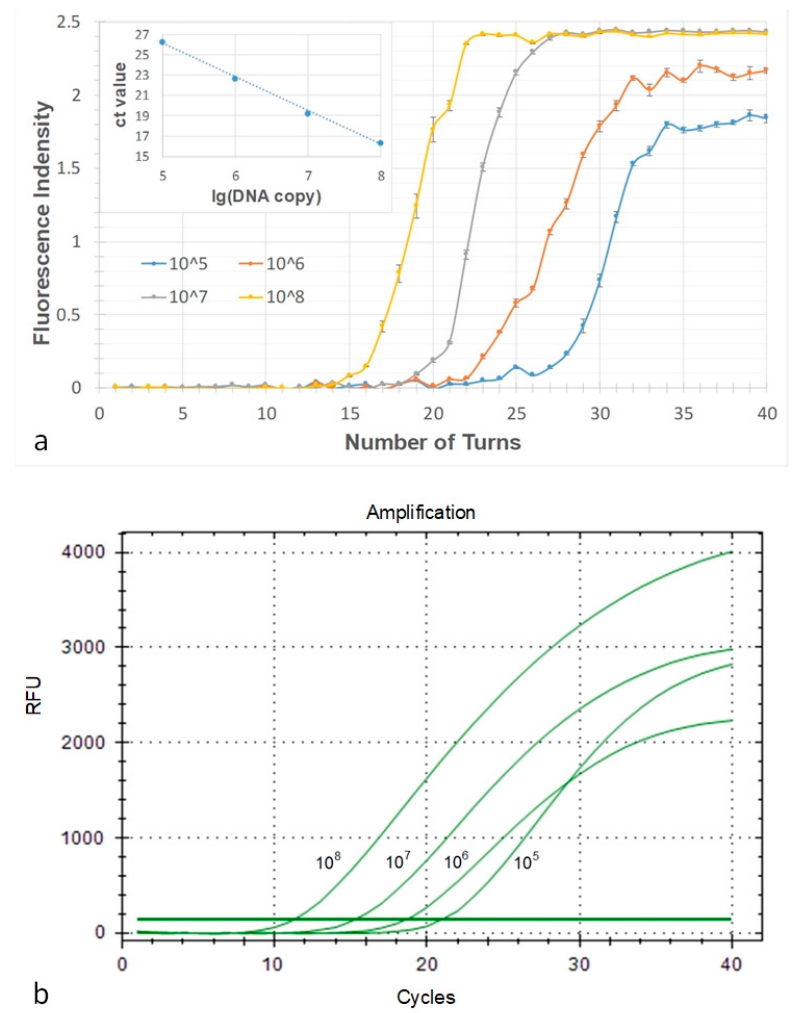
Figure 8. Results of real-time fluorescence detection. ( a ) The amplification curves gained from the fluorescence images of serial diluted DNA molecules of the microdevice. ( b ) Amplification curves from the commercial Real-time PCR amplification system.